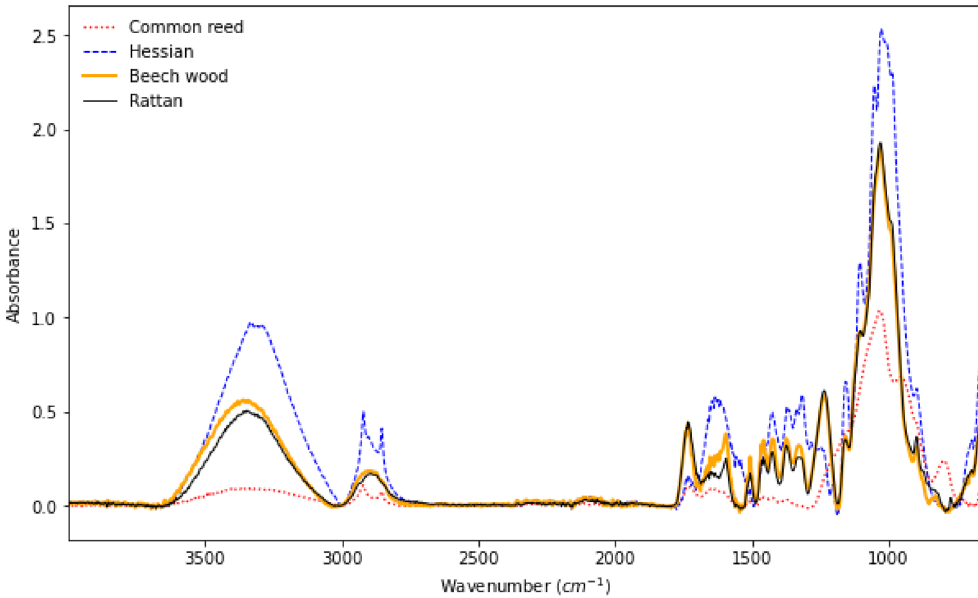
Figure 1. FTIR spectra of hemp-based hessian, beech wood, rattan, and common reed